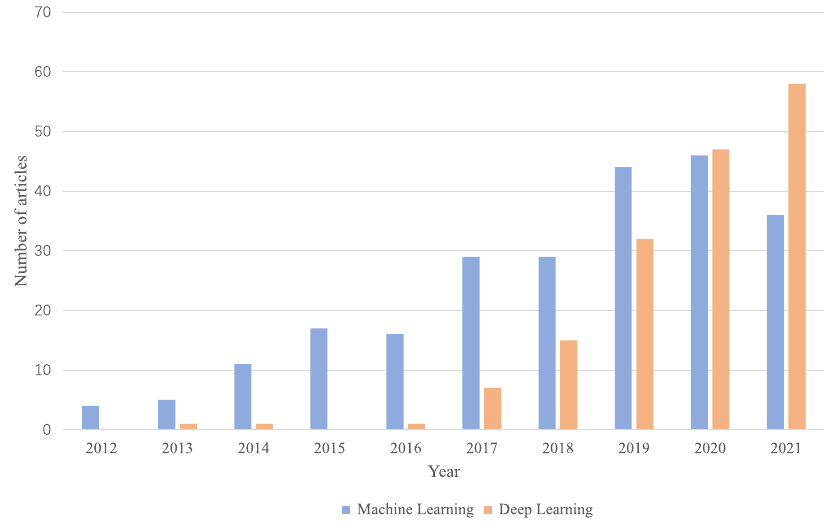
Fig. 2 NLP trends applied to mental illness detection research using machine learning and deep learning. The trend of the number of articles containing machine learning-based and deep learning-based methods for detecting mental illness from 2012 to 2021.